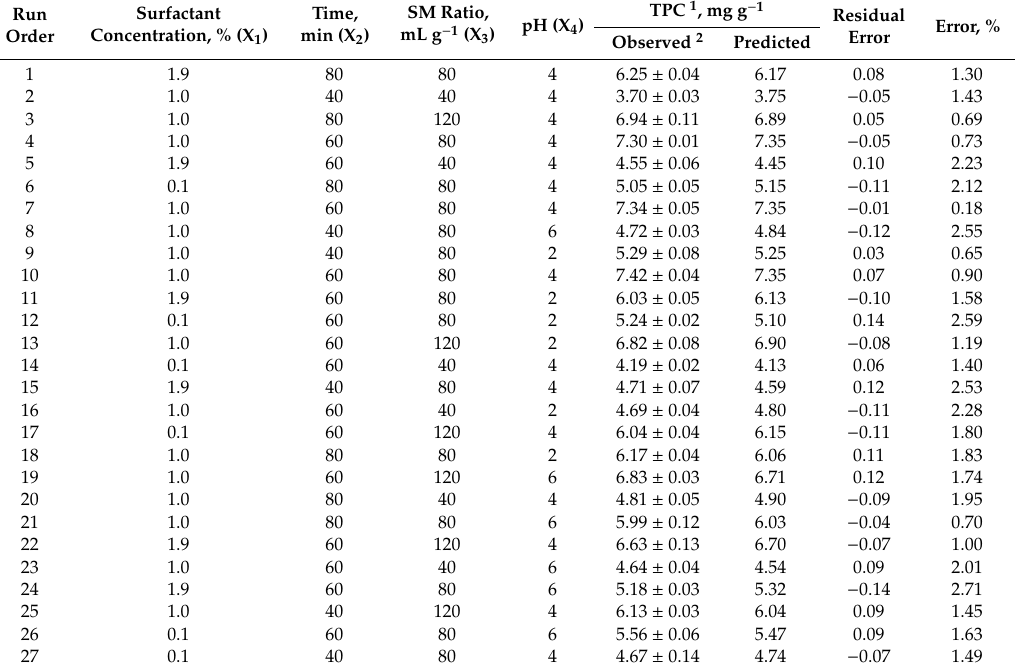
Table 2. Box–Behnken design with observed experimental and predicted